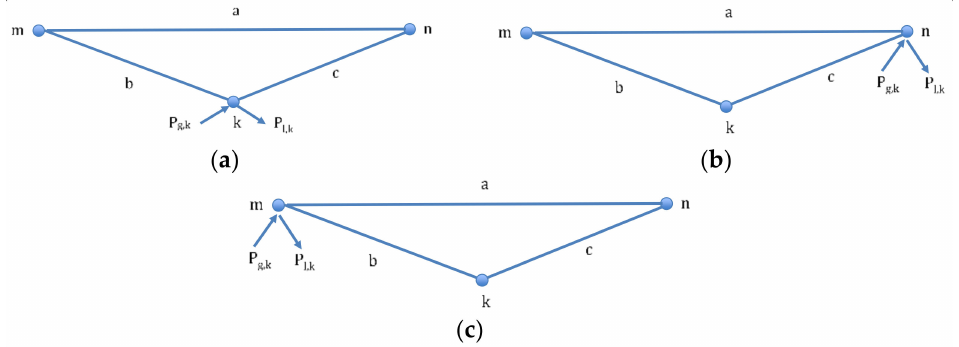
Figure 4. Topology for multiple line outage: ( a ) real; ( b ) variation for the double outage a + b ; ( c ) variation for the double outage a + c